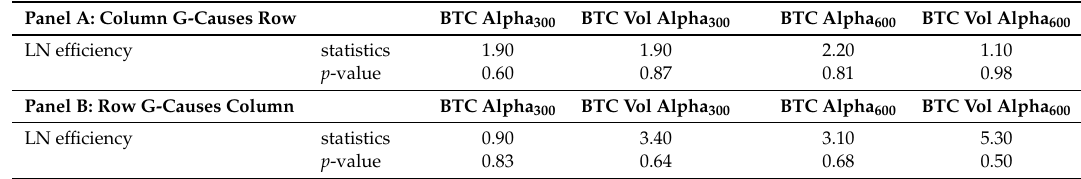
Table A1. Testing for Granger-causality. The table reports the results of the Toda–Yamamoto test (Toda and Yamamoto 1995). In Panel A we test whether column variables Granger-cause the row variable, while the opposite for Panel B. To compute the DFA, we consider time windows of length n = 300 for the first two columns and n = 600 for the last two. Panel A: Column G-Causes Row BTC Alpha 300 BTC Vol Alpha 300 BTC Alpha 600 BTC Vol Alpha 600 LN efficiency Panel B: Row G-Causes Column BTC Alpha 300 BTC Vol Alpha 300 BTC Alpha 600 BTC Vol Alpha